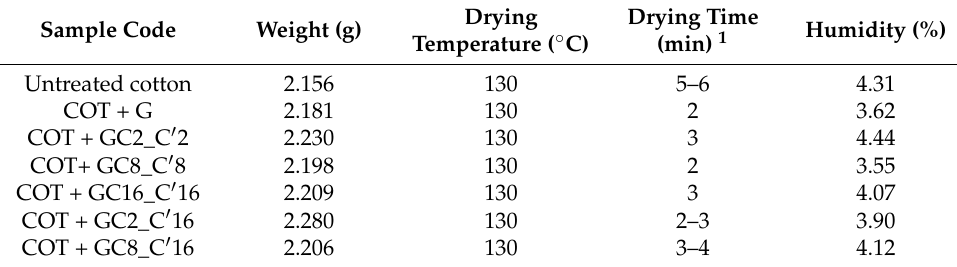
Table 6. Moisture-adsorption standard test.